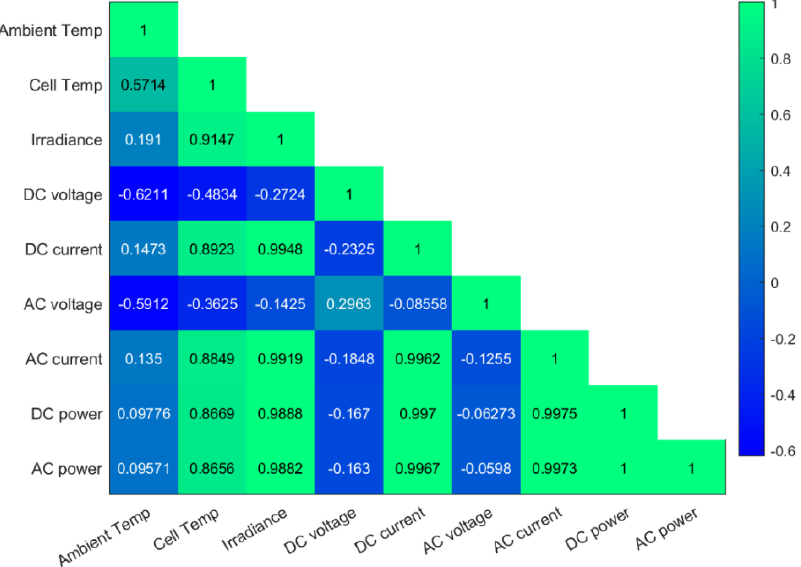
Figure 8. Correlation matrix of training PV data.